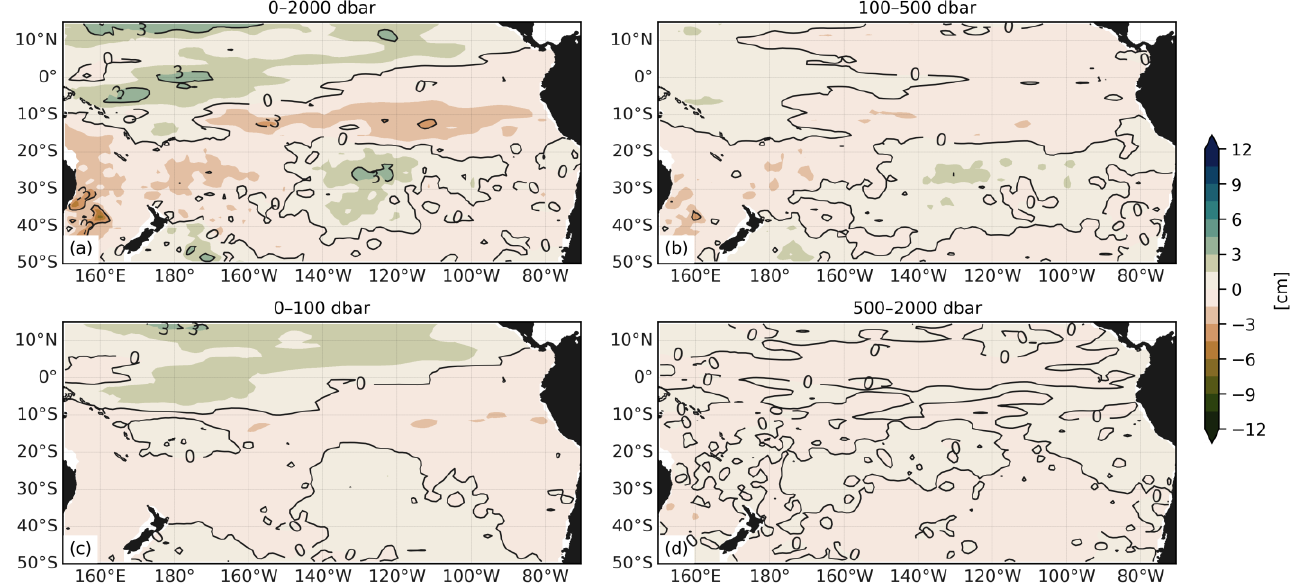
Figure 4. Differences in the Roemmich-Gilson Argo-based halosteric sea level (HSL) for 2016 minus 2014 over ( a ) 0 – 2000 dbar, ( b ) 100 – 500 dbar, ( c ) 0 – 100 dbar and ( d ) 500 – 2000 dbar. Contour lines (see inline numbers for HSL intervals) are also shown.